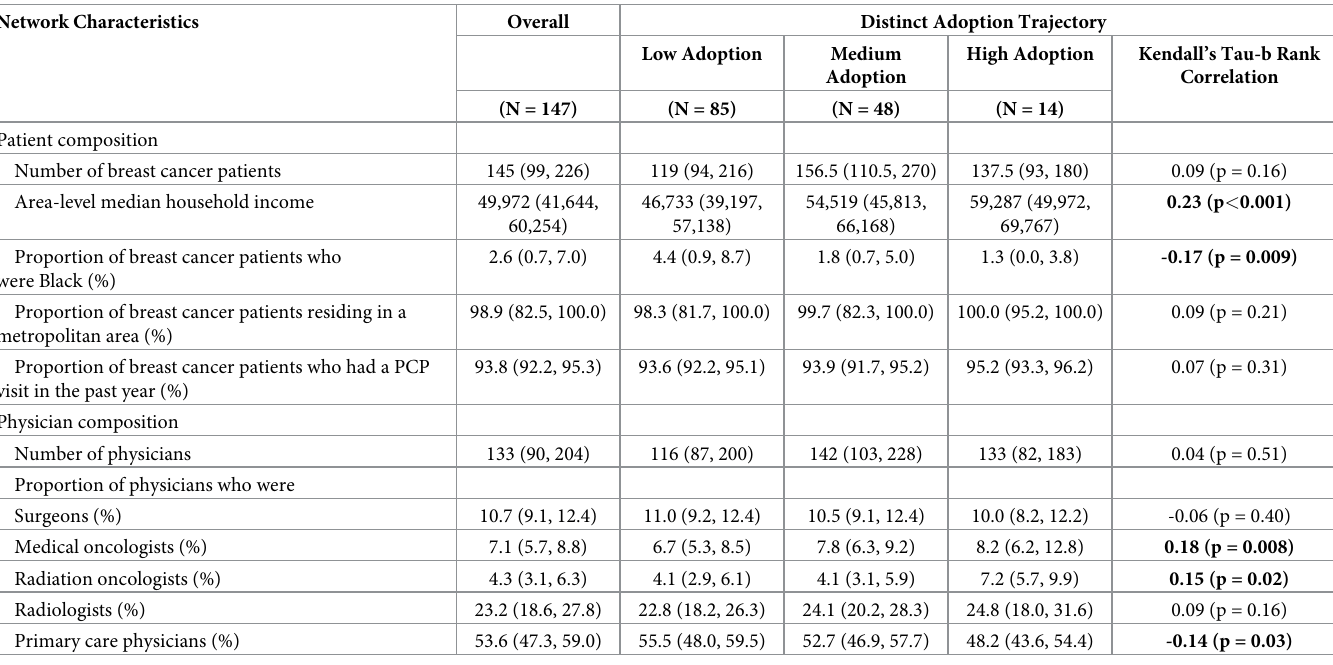
Table 2. Characteristics of physician patient-sharing networks, overall and across the distinct trajectory groups (N = 147 physician patient-sharing networks). Network